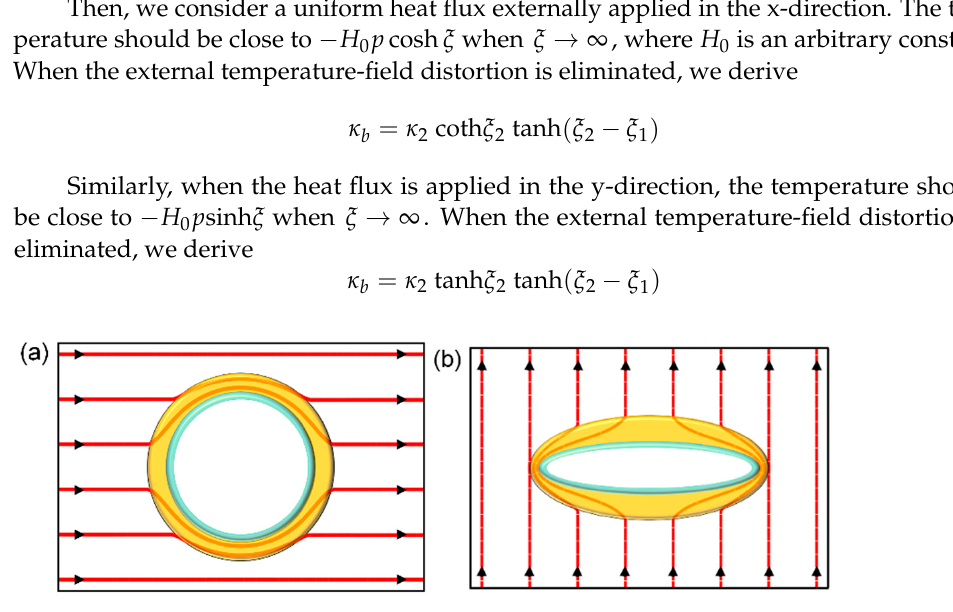
Figure 3. Functional demonstration of bilayer thermal cloak: ( a ) circular shape, ( b ) elliptical shape. The red lines illustrate the heat flux distributions.